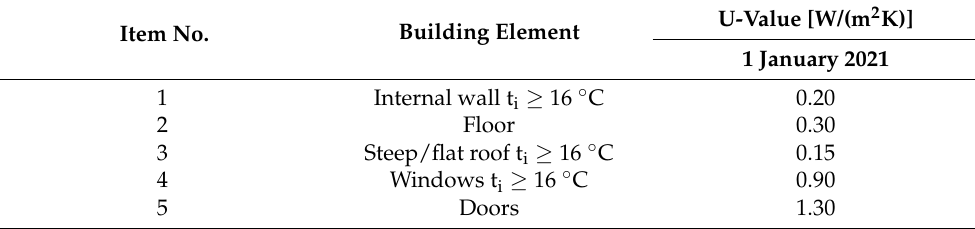
Table 1. Heat transfer coefficient U [W/(m2K)] for selected building elements. Item